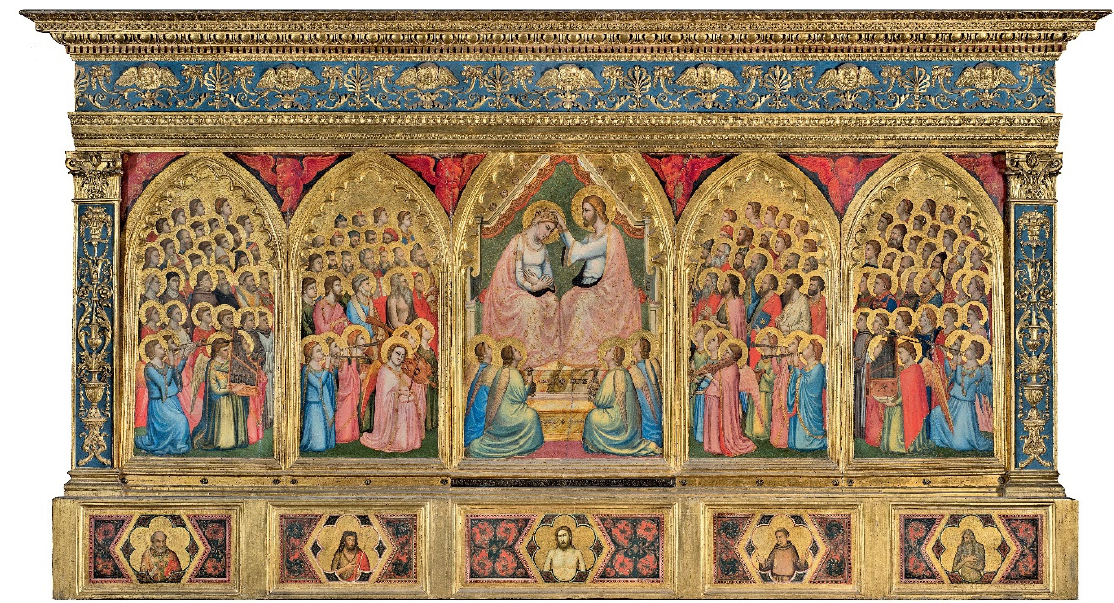
Figure 3. Giotto di Bondone, The Coronation of the Virgin with angels and saints ( Baroncelli Polyptych